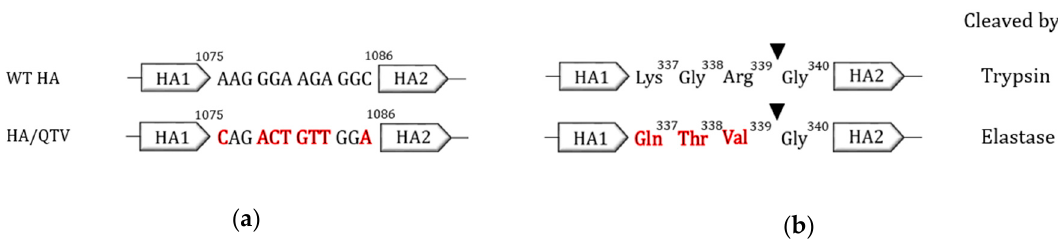
Figure 1. The schematic outline of the mutations introduced into the HA cleavage site of BC15 (H7N9). ( a ) Nucleotide sequences from HA positions 1075 to 1086 and ( b ) amino acid sequences from HA positions 337 to 340 of WT HA (wild type) and HA / QTV (mutant plasmids). Nucleotide sequences ( a ) and amino acids ( b ) in red correspond to the mutations that were introduced. Elastase corresponds to the human neutrophil elastase protease.